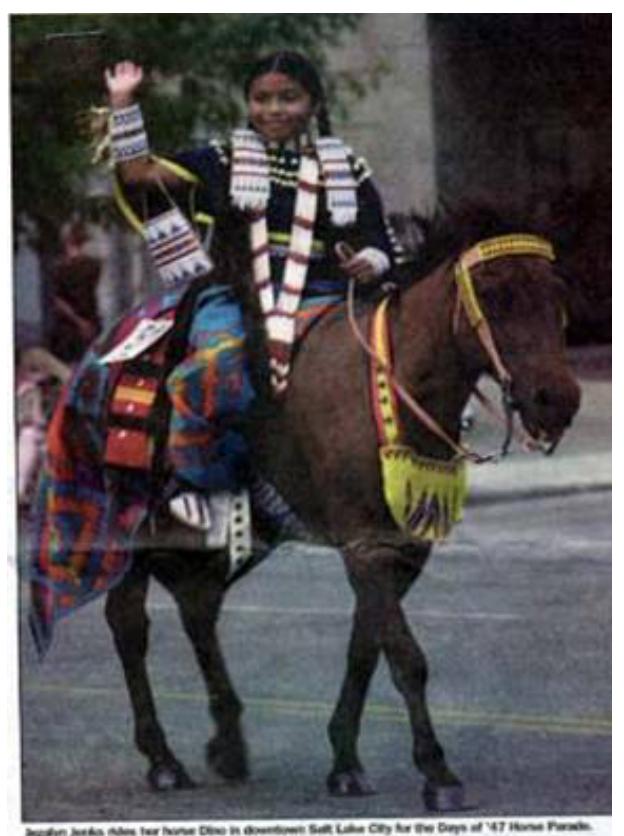
Figure 2. Salt Lake City’s Days of ’47 Parade